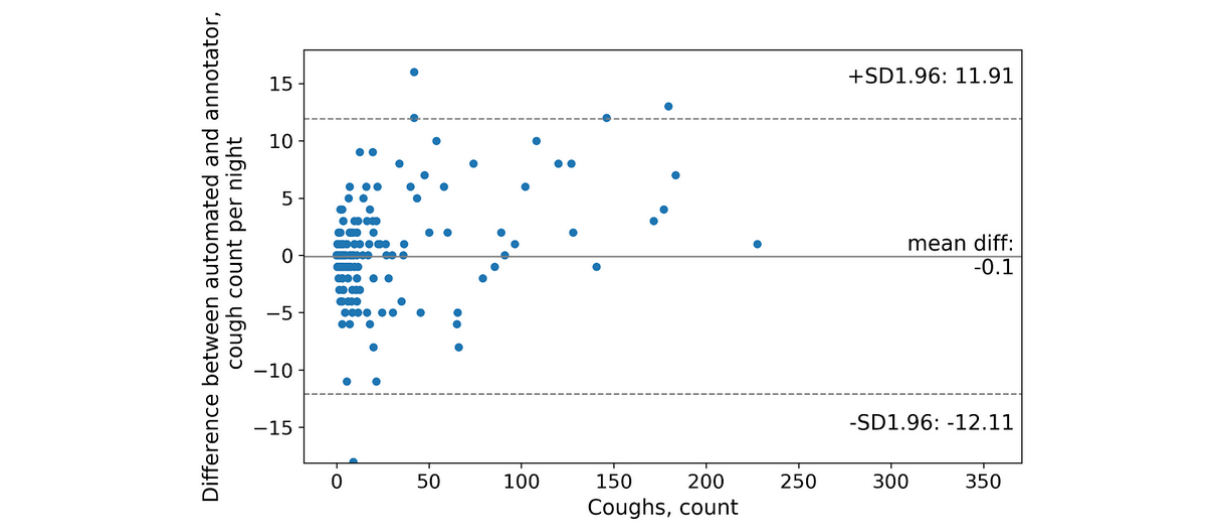
Figure 4. Bland-Altman plot of the automated and annotator cough counts per